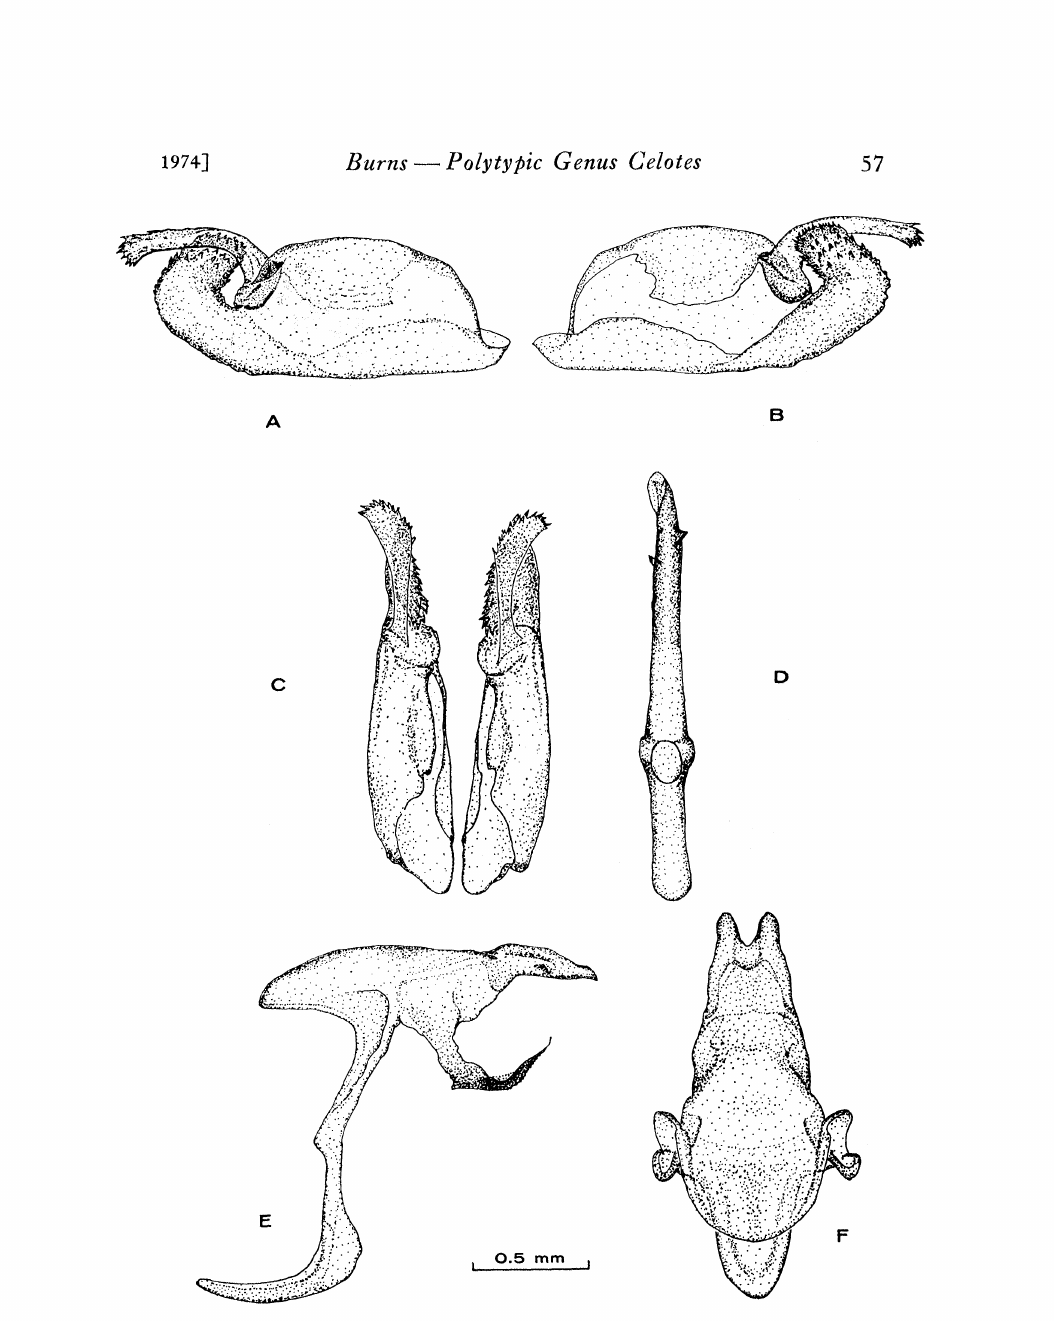
Fig. 4. Male genitalia of Celotes limpia. A to F as in fig. 3. [A and B, drawn from holotype; C to F’, from paratype from type locality, V-4-1959 (J. M. and S. N.